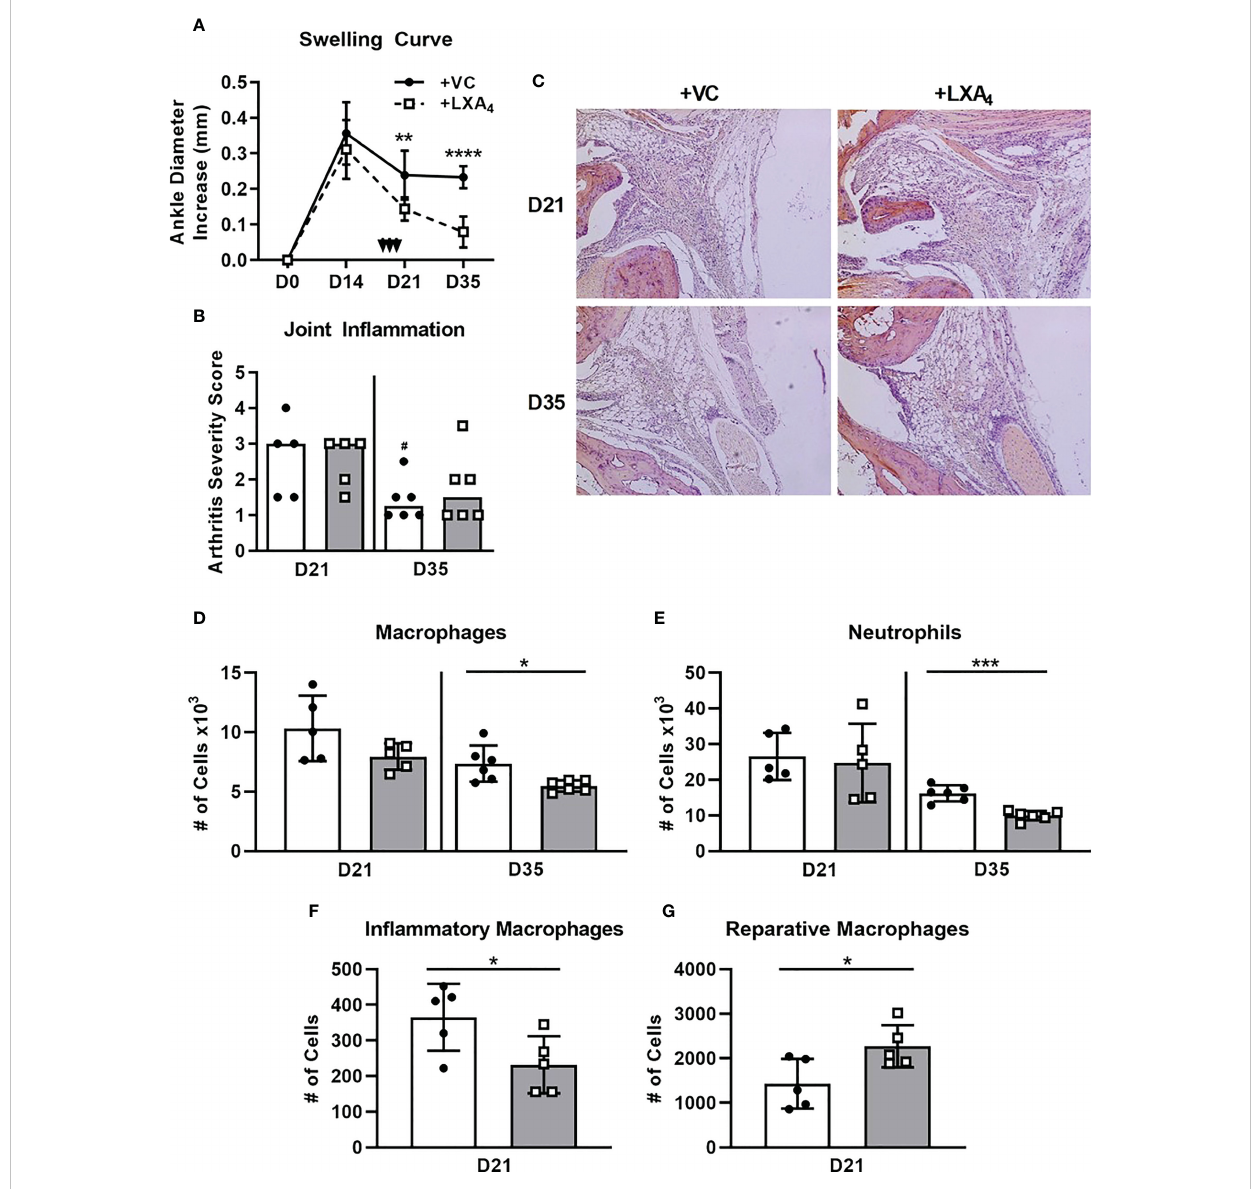
FIGURE 6 Exogenous LXA4 treatment reduces ankle edema and accelerates joint in fl ammatory cell removal. C3H WT mice were infected with B. burgdorferi and treated with either vehicle control (VC; closed circles, solid line) or LXA4 (open squares, dotted line) i.p. on days 18,19, and 20pi (arrows). Development of mLA was followed over time. (A) Ankle diameters were measured on the days indicated. n=5/group. **p<0.01, ****p<0.0001 by t- test between treatment groups per timepoint. (B) Arthritis severity scores of H&E-stained ankle joints from mice sacri fi ced on D21 and D35. VC (closed circles, open bars), LXA4 (open squares, grey bars). Bars represent median values. n=5-6/group. # p<0.05 by Mann-Whitney U test compared to D21 of the respective strain. Representative histology is in (C) . Total macrophages (D) and neutrophils (E) quanti fi ed from the ankle joints of VC- (closed circles, open bars) or LXA4-treated (open squares, closed bars) WT mice at D21 and D35 by fl ow cytometry. Two macrophage subsets were further measured in D21 ankles: in fl ammatory macrophages (F; CD45.2+F4/80+Ly-6Chi) and reparative macrophages (G; CD45.2+F4/80+Ly-6Cint/ lo). n=5/group. *p<0.05 by t-test between treatment groups per timepoint. Data from two experiments were combined to reach power in D35 groups (A, B, D, E) .